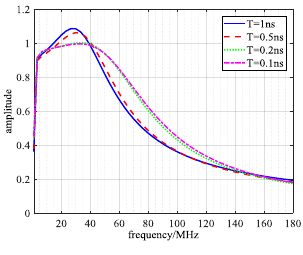
Fig. 1. Time-domain waveforms of B sensor. Fig. 2. H ( z )